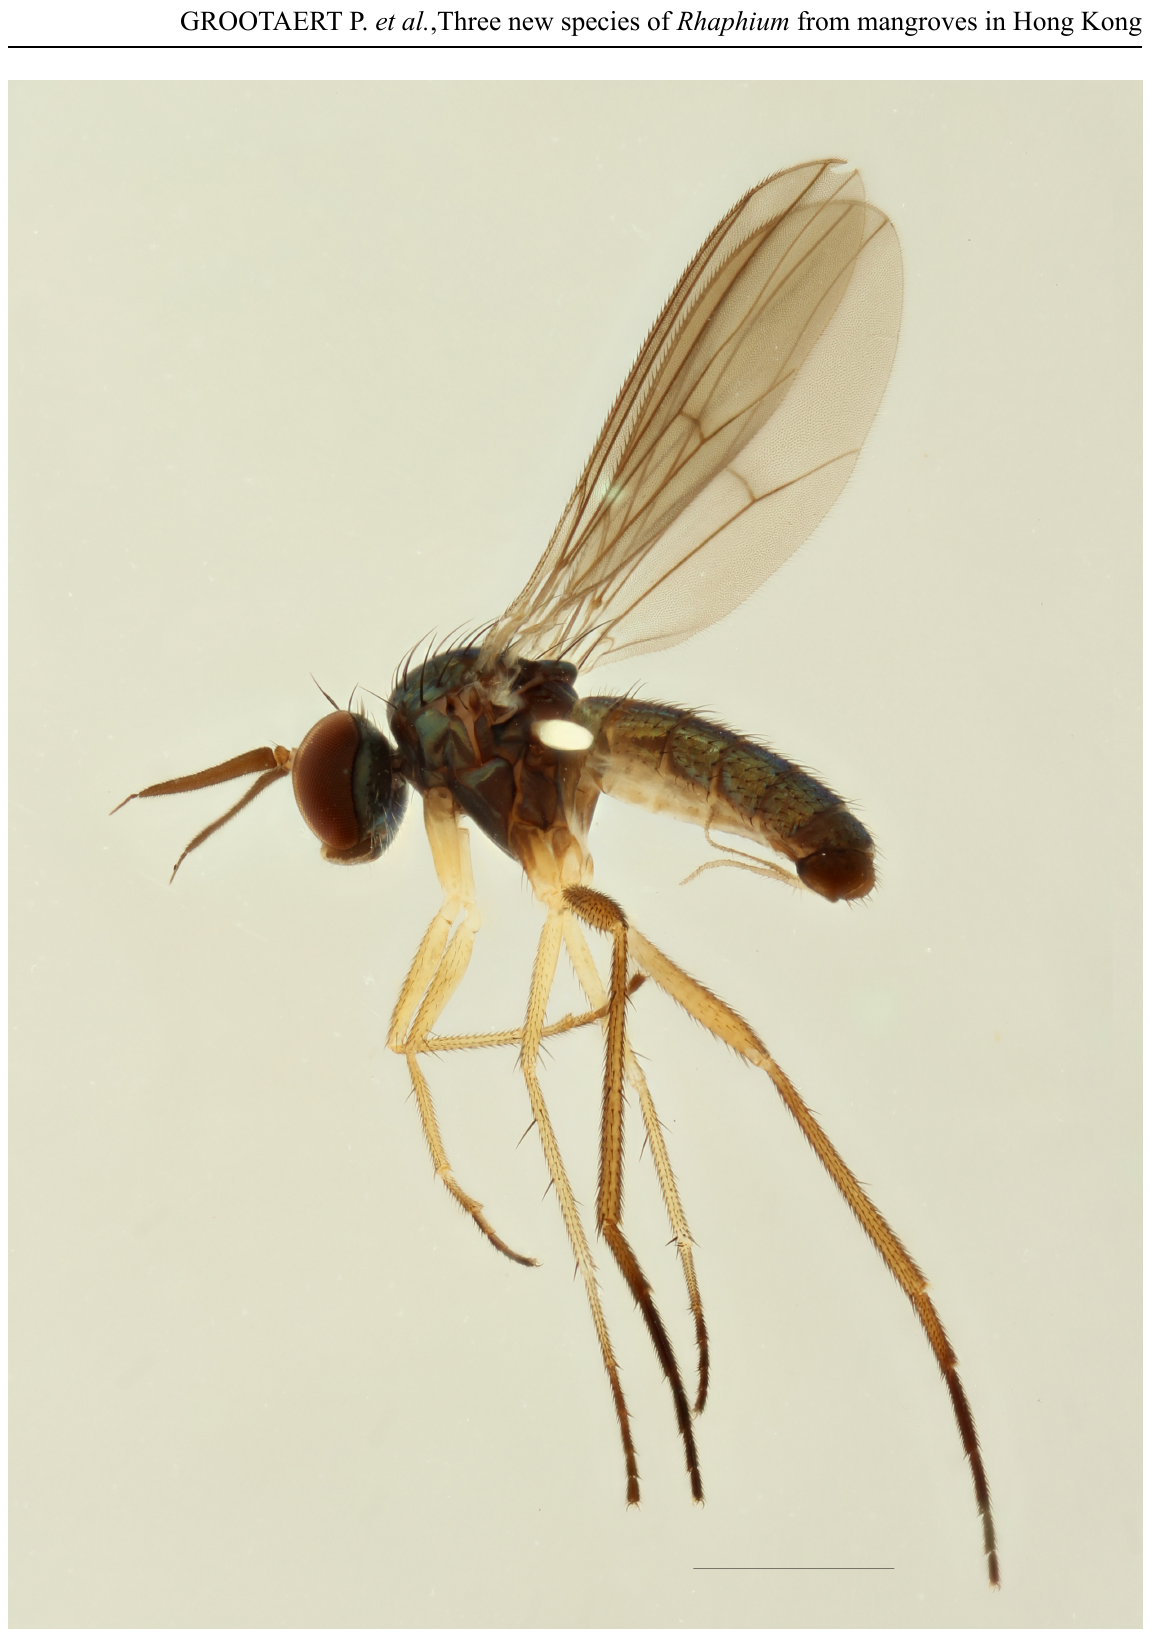
Fig. 1. Rhaphium hongkongense sp. nov., holotype, ♂, habitus (RBINS). Scale bar: 1 mm. (Photo credit Ms